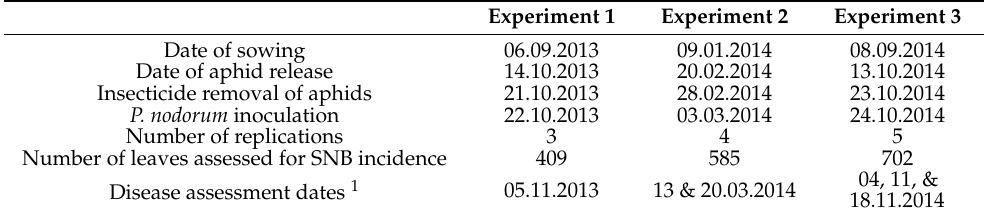
Table 2. Dates of wheat seed sowing, aphid release, insecticide application, inoculation of P. nodorum and total number of leaves included for disease incidence assessment on the different